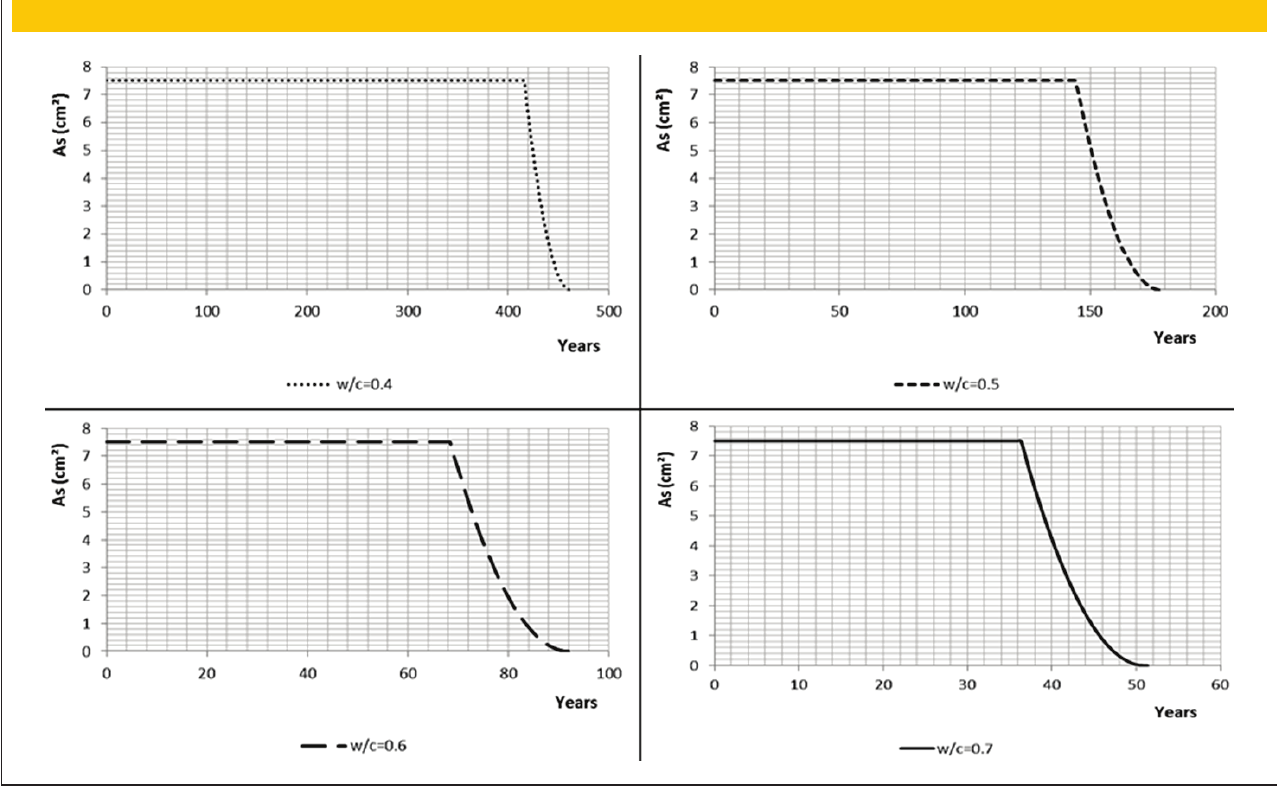
Figure 11 – Initiation and propagation periods considering CA II and β